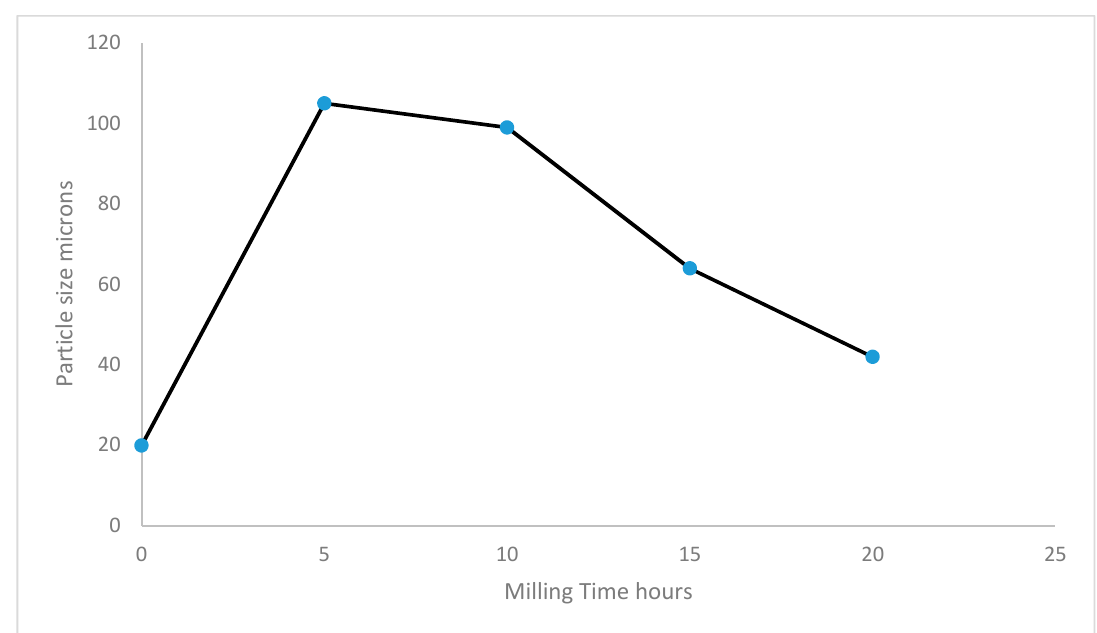
Figure 3. Particle size of the as-milled NiMnFeCu powders as a function of milling time.